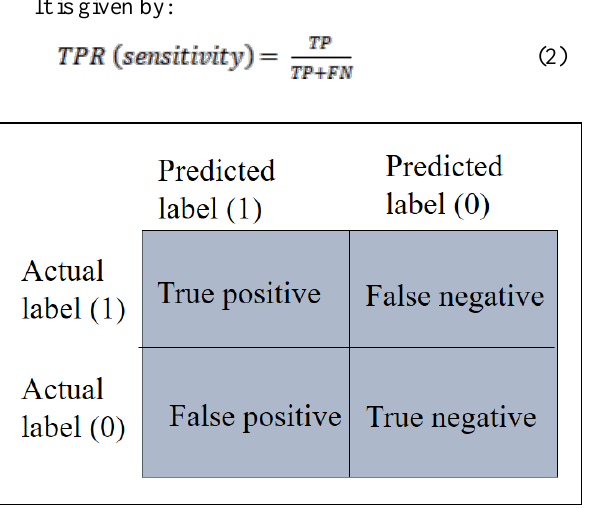
Figure 2. Confusion Matrix for classification